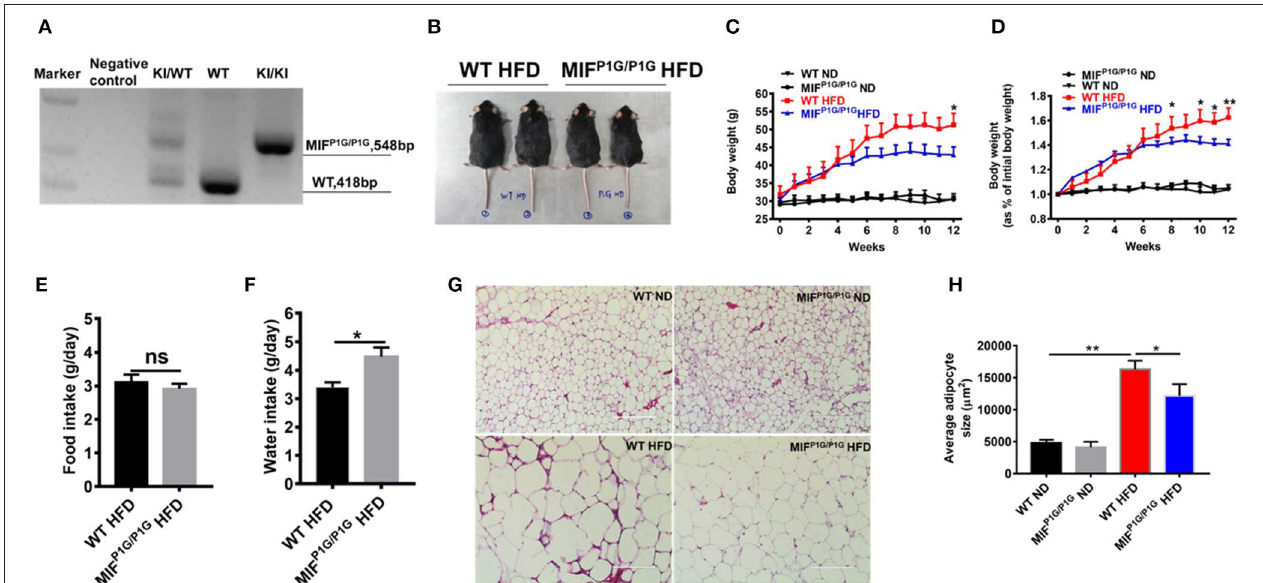
FIGURE 2 | MIF P1G / P1G mice protected mice from HFD-induced obesity. (A) The MIF P1G / P1G mouse genotype was identified by RT-PCR. (B) An image of the mice fed with high-fat diet (HFD). Four month-old wild-type (WT) and tautomerase-null macrophage migration inhibitory factor (MIF P1G / P1G ) mice were fed with HFD for 12 weeks. (C) The bodyweights of the WT and MIF P1G / P1G mice which were fed with ND or HFD were measured every week. (D) The gain curves of bodyweight of mice. The percentage of the bodyweight gain was represented with the initial bodyweight of the mice as a control. (E) The food intake between the two groups under HFD. (F) The water intake between the two groups under HFD. (G) The morphological analysis of Hematoxylin and eosin staining in adipose tissue from the two group mice under ND or HFD. (H) The measurement of adipocyte cross-sectional surface area from the two group mice under ND or HFD. Data are shown as mean ± SEM, * p < 0.05 and ** p < 0.01, n = 5–6 per